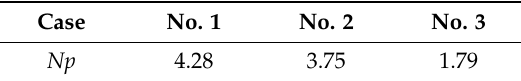
Figure 5. Velocity contours for Re = 10. Table 3. Power number for Re = 10.